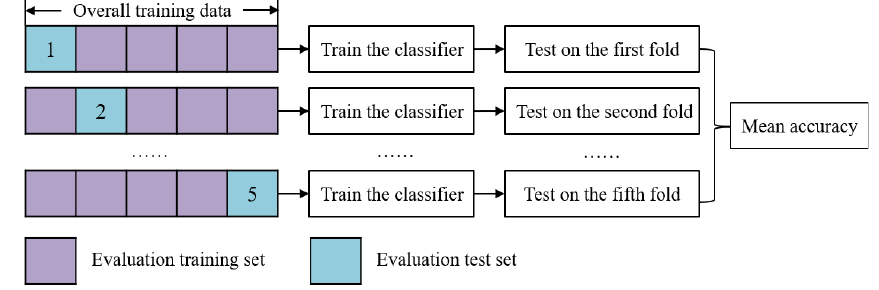
Figure 6. Illustration of the five-fold cross-validation with a classification algorithm.